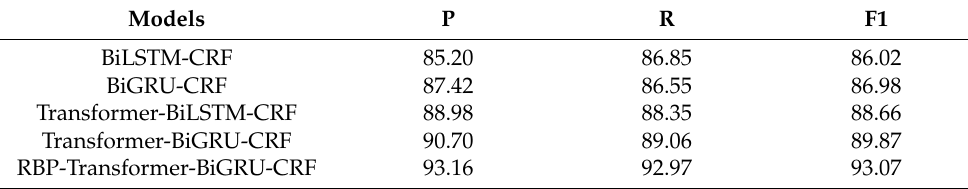
Table 5. Results of the different methods for character vector